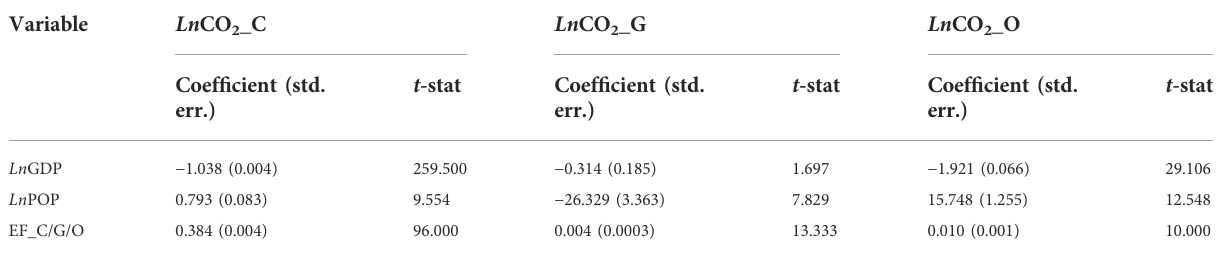
TABLE 4 Results for the Johansen model.